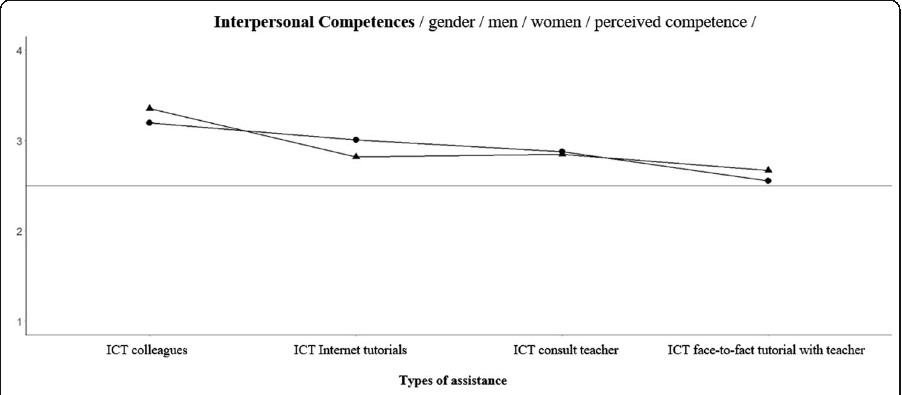
Fig. 2 Interpersonal competences in the use of